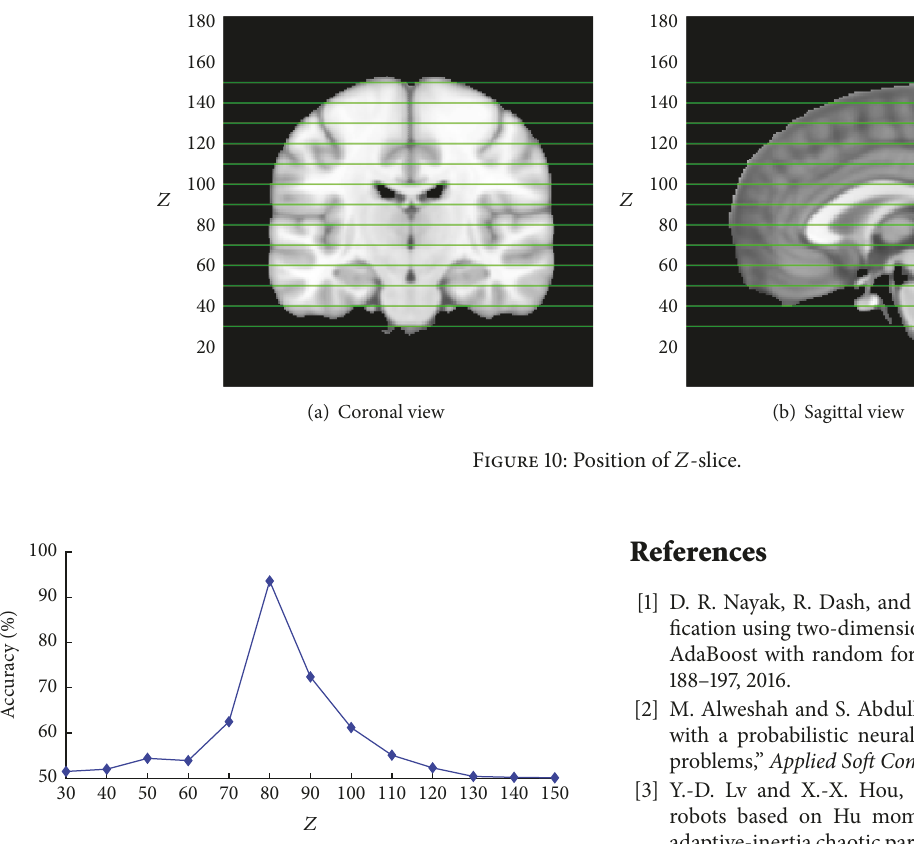
Figure 11: Classification performance changes with slice index 𝑍